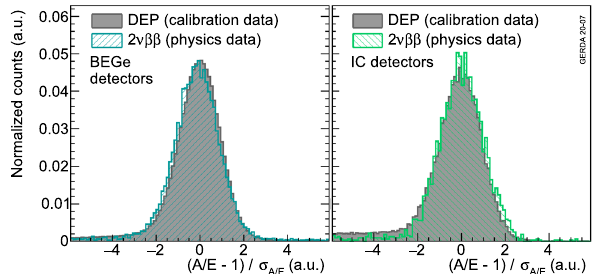
Fig. 9 A / E classifier distributions after LAr veto comparing events in the DEP from calibration data and 2 νββ decay events from physics data from BEGe (left) and IC (right) detectors. The histograms are normalized to their integrals